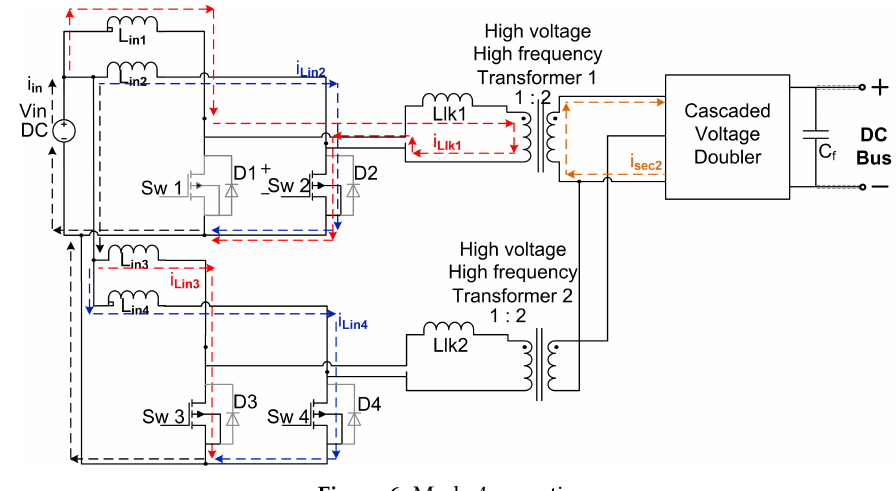
Figure 6. Mode 4